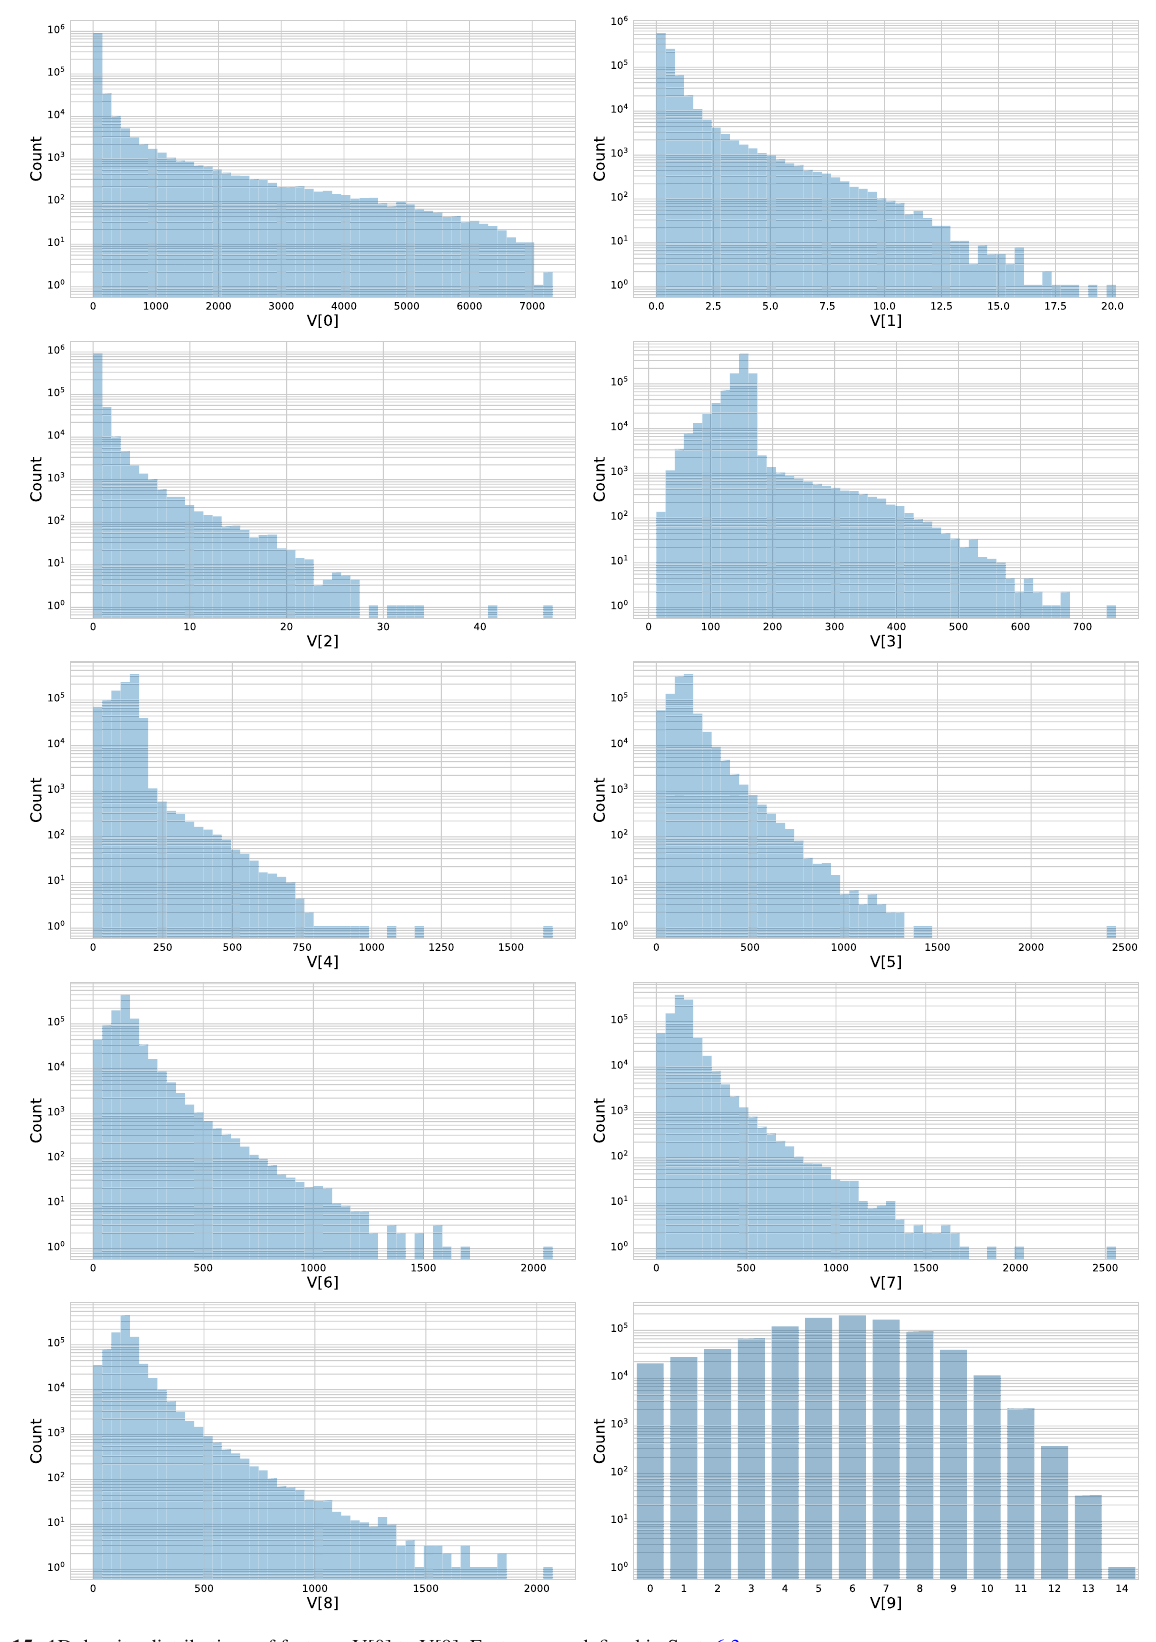
Fig. 15 1D density-distributions of features V[0] to V[9]. Features are defined in Sect.